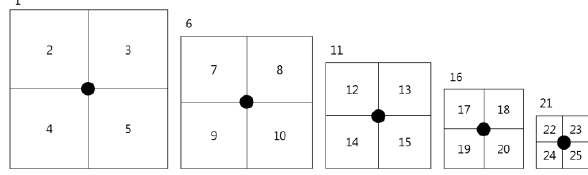
Figure 1. Multi-Dimensional Search window (5 step)